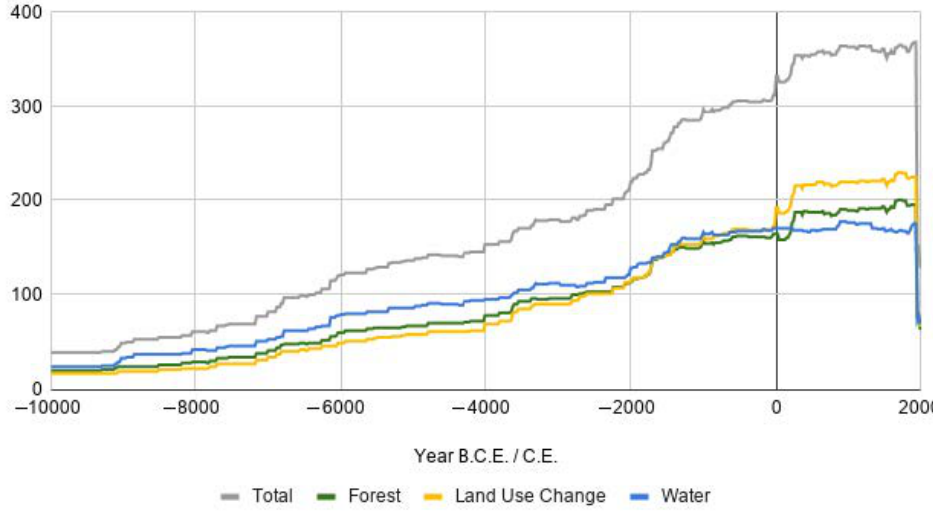
Figure 8. Number of studies and temporal coverage of the Holocene in 20-year time slices.